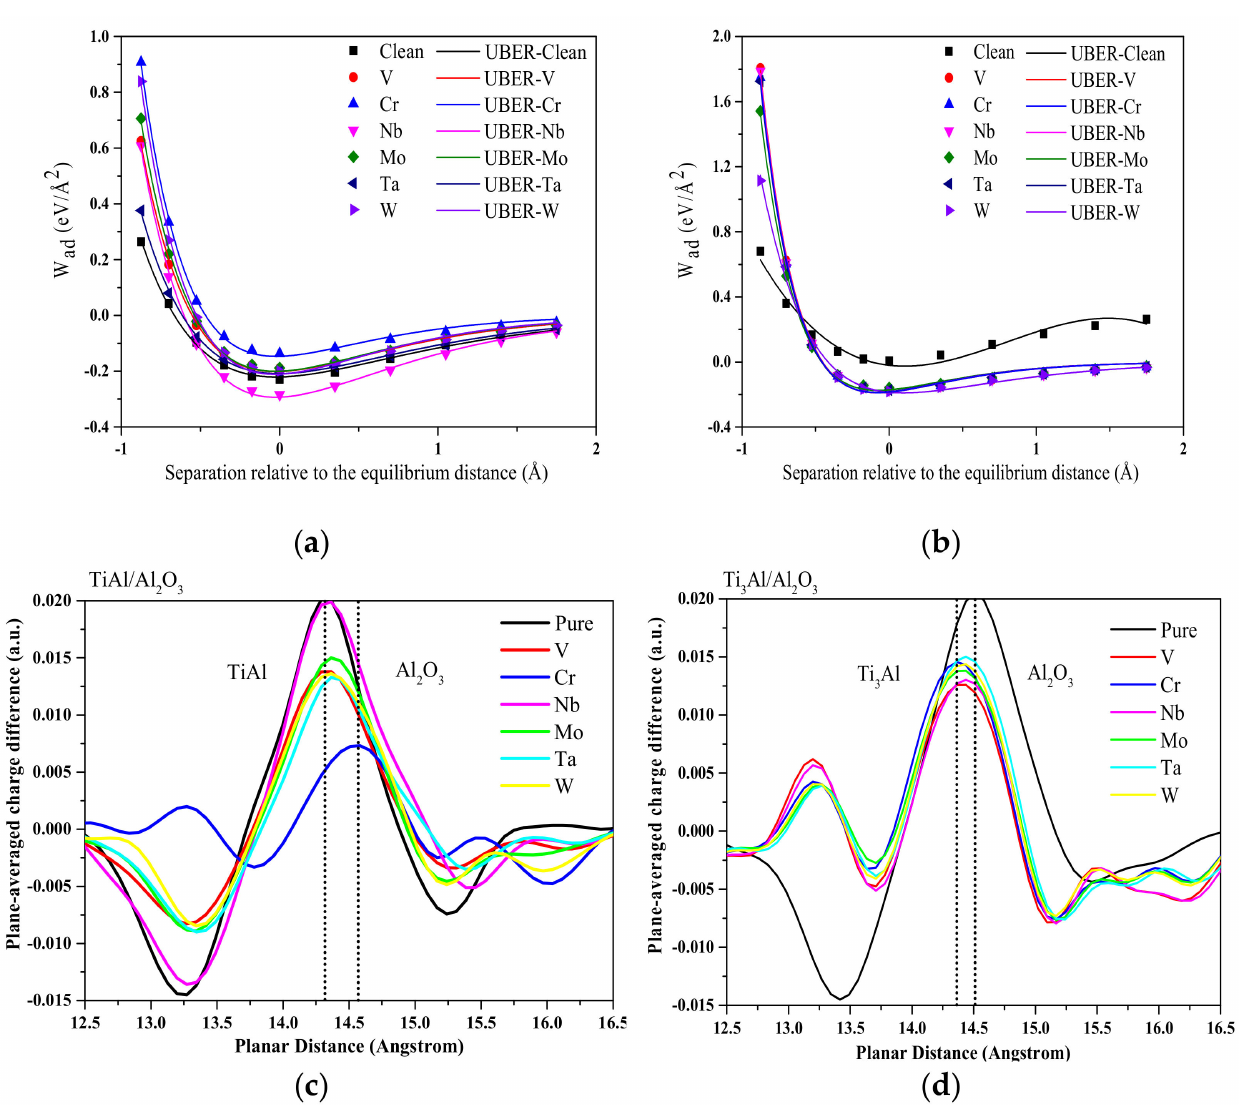
Figure 3. Variation of work of adhesion via the separation of ( a ) γ -TiAl/Al 2 O 3 and ( b ) α 2 -Ti 3 Al/Al 2 O 3 . Differences of PACs between interface and separated slabs displayed along the direction perpendicular to the interface ( c ) γ -TiAl/Al 2 O 3 and ( d ) α 2 -Ti 3 Al/Al 2 O 3